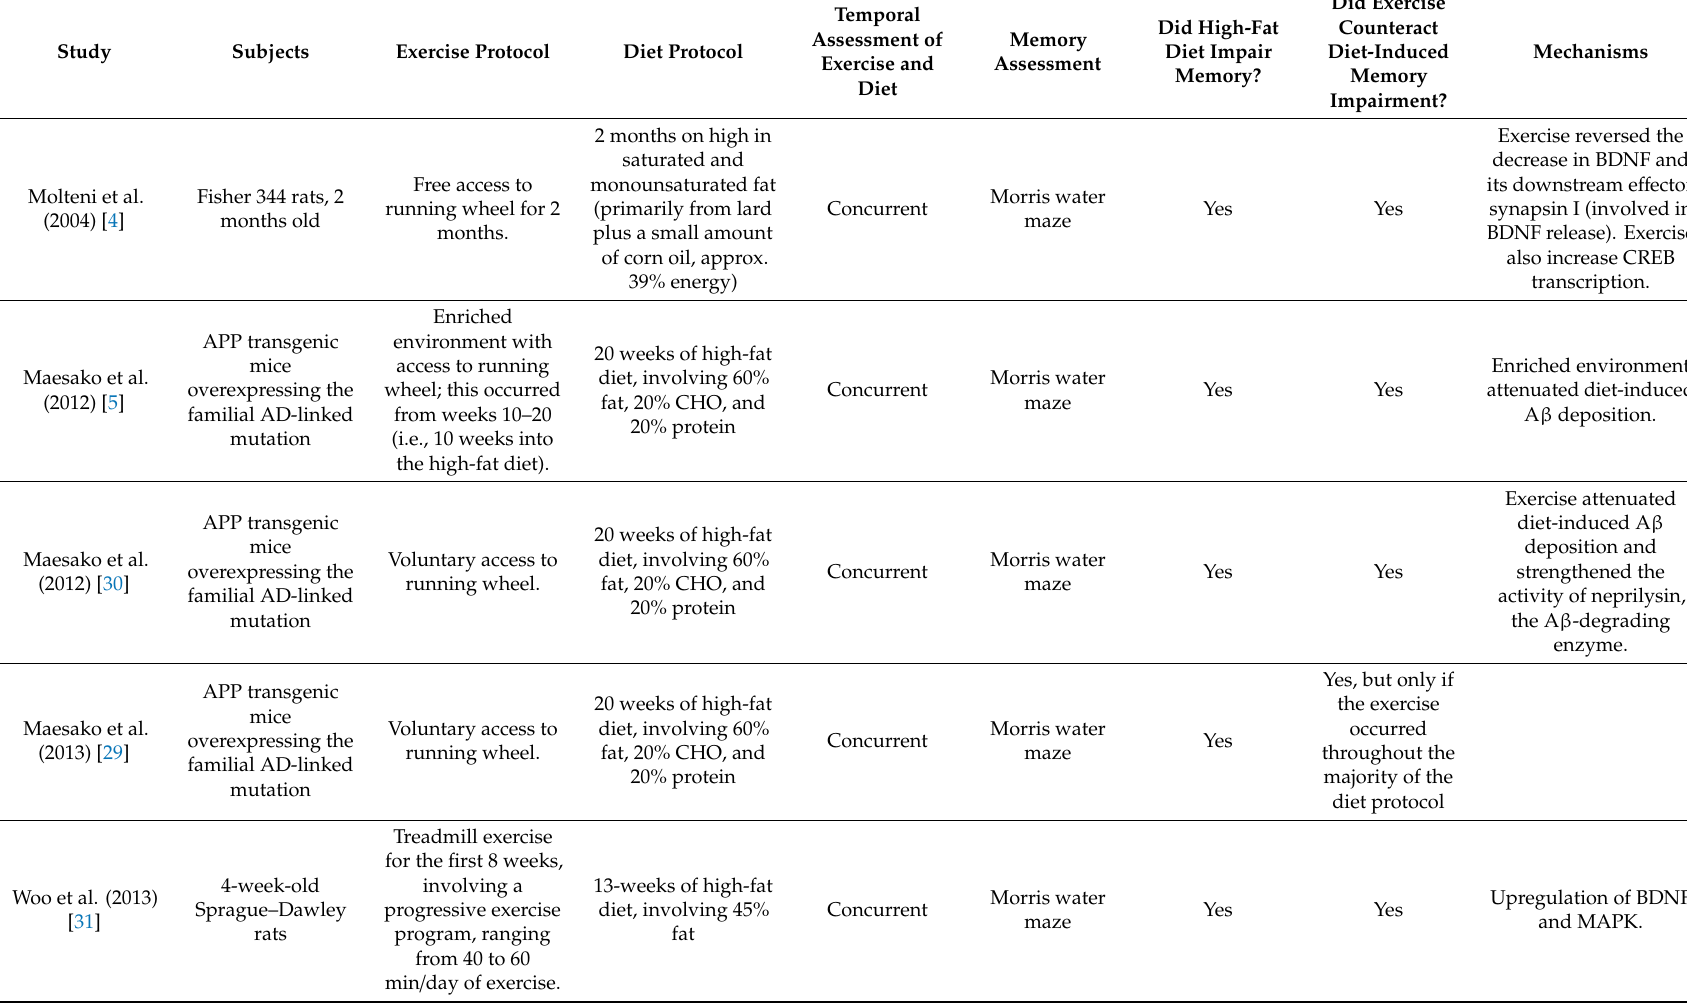
Table 1. Extraction table of the evaluated